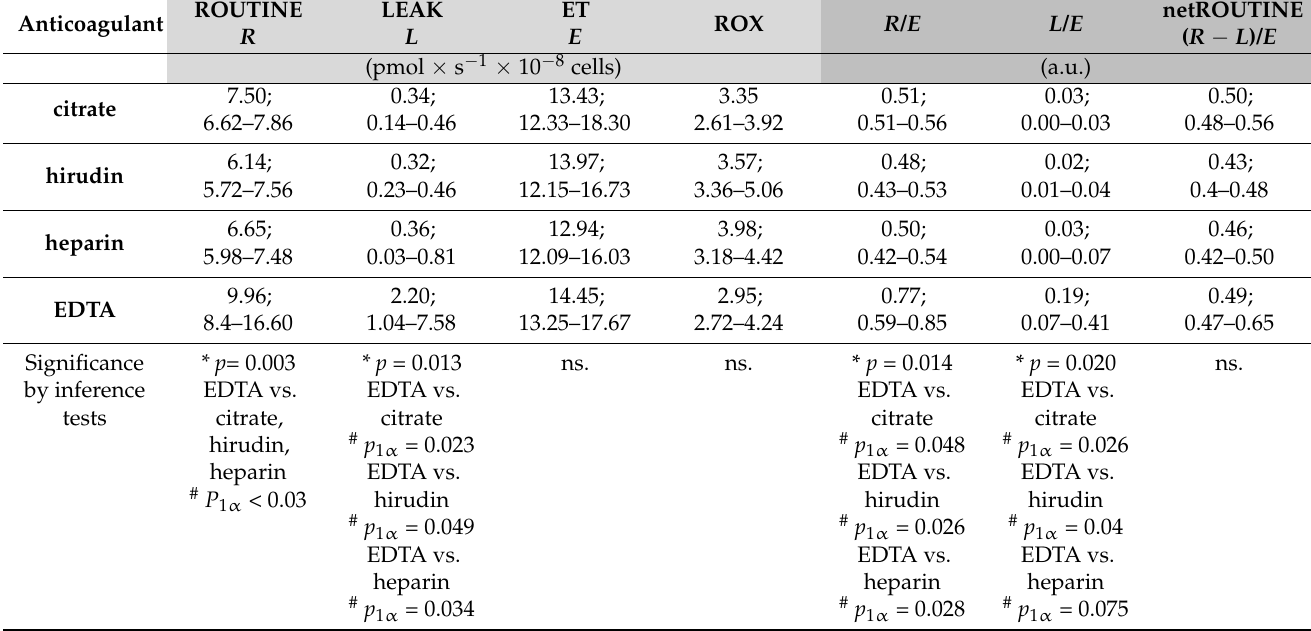
piration for EDTA samples was the result of an increased uncoupling/dyscoupling of respiration, and it was not related to elevated energy demands (Table 1). Table 1. Mitochondrial respiration parameters and non-mitochondrial respiration of blood platelets in autologous plasma obtained from blood collected using various